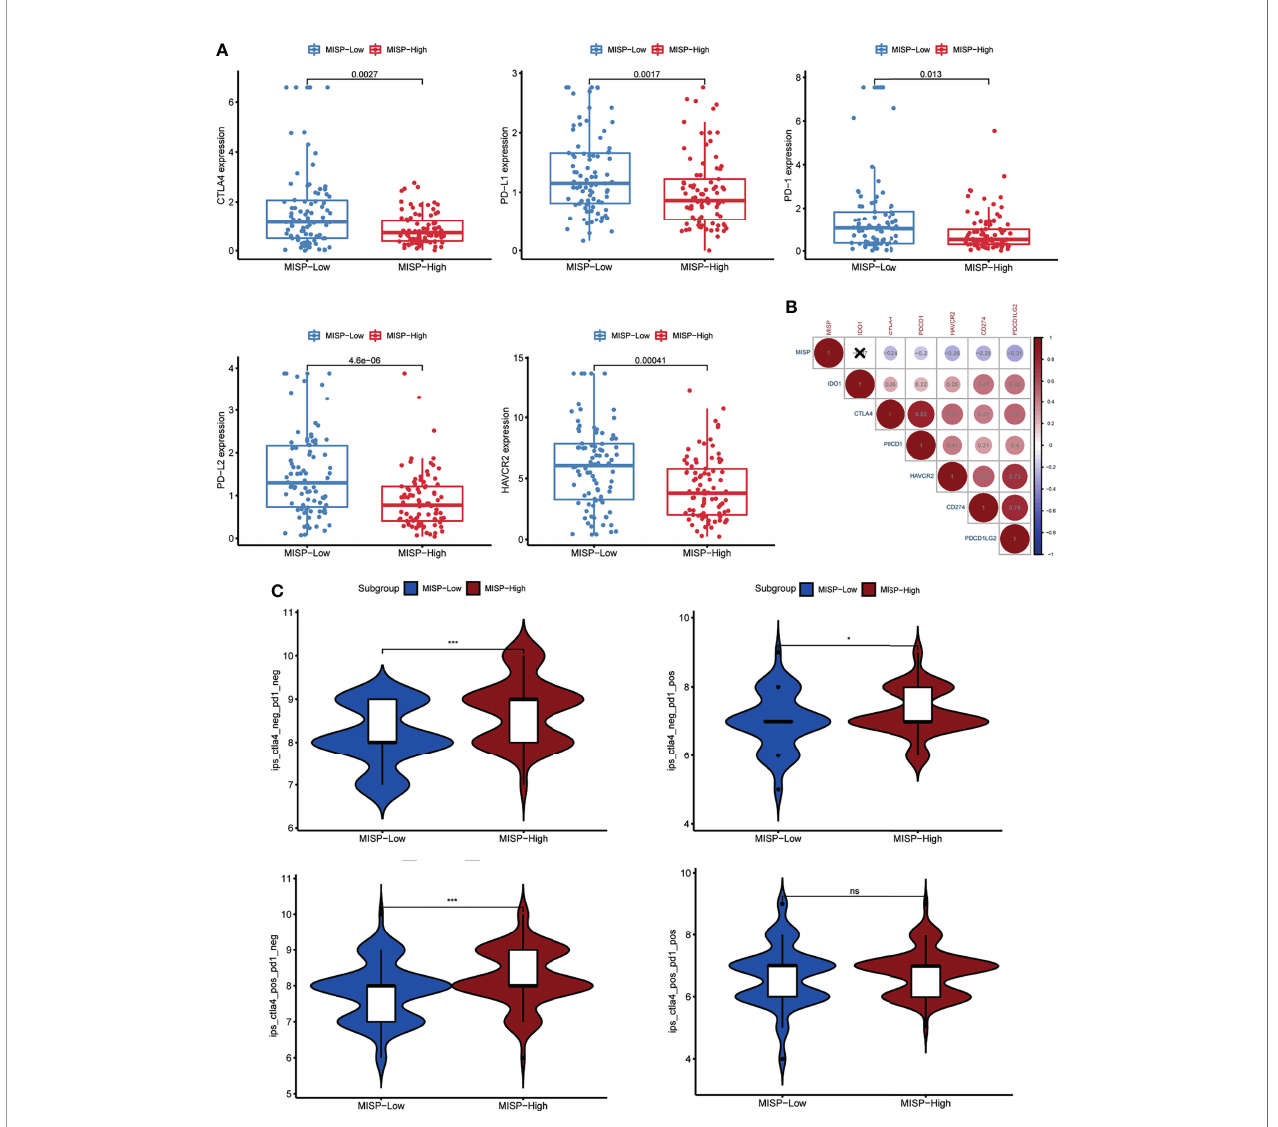
FIGURE 8 | The association between MISP expression and response to immune checkpoint inhibitors (ICI). (A) The gene expression of PD-1, PD-L1, CTLA-4, PD- L2 and HAVCR2 in the high-MISP and low-MISP groups. (B) Pearson ’ s correlation test was used to explore the correlation of paired IC genes and MISP. (C) The difference of IPS between the high- and low-MISP subgroups. *P<0.05; ***P<0.001; ns, not signi fi